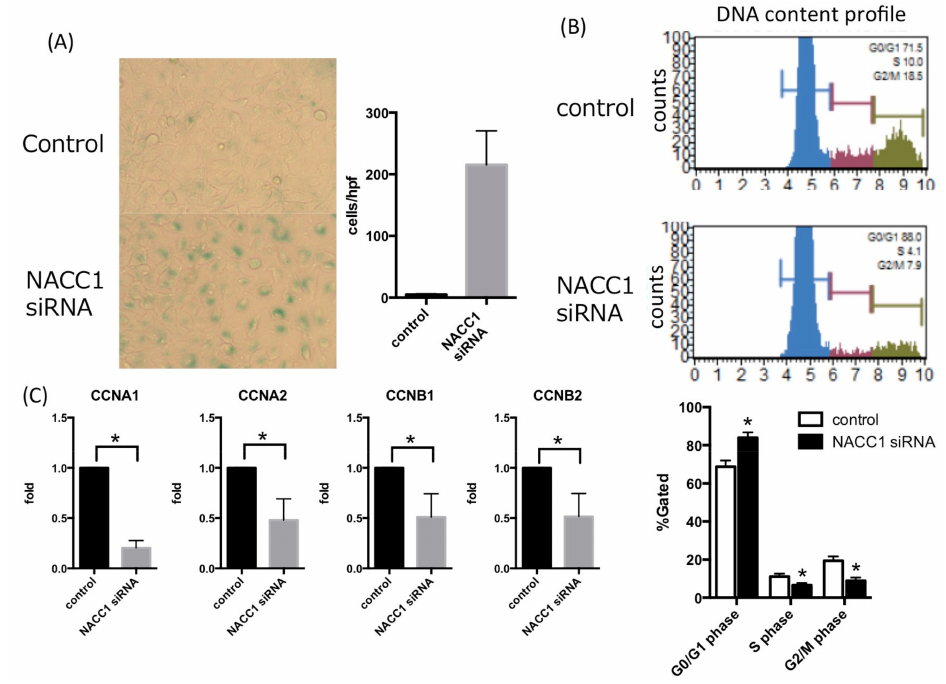
Figure 3. ( A ) Senescence-Associated β -Galactosidase (SA- β -gal) assay. Senescent cells with SA- β -galactosidase activity were significantly induced, scale bar: × 100; ( B ) The cell cycle assay for UC cells. Cell cycle arrest at G0/G1 phase was induced in T24 cells. (* p < 0.05); ( C ) mRNA expression of cyclin A and B under suppression of NACC1 in T24 cells. (* p <